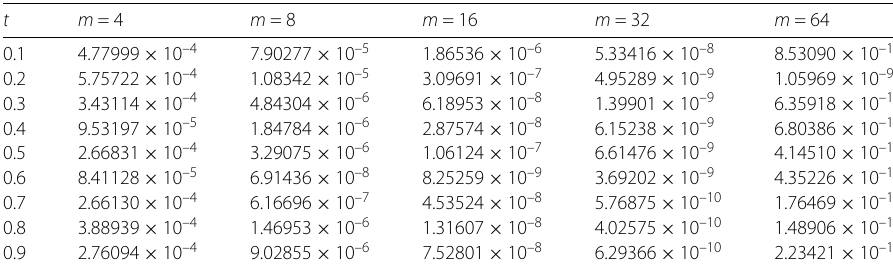
Table 4 Absolute error for ρ = 1.75, α = 1.45 and for several fixed values of